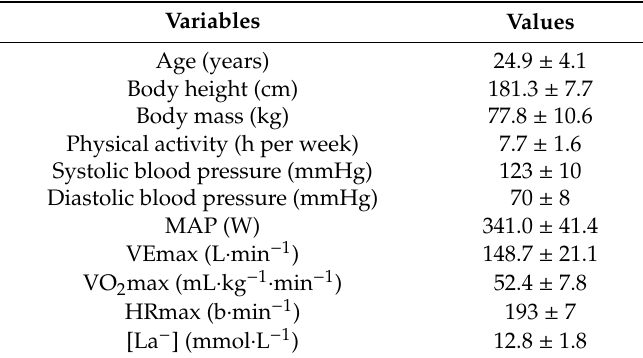
Table 1. Participants’ characteristics ( x ±